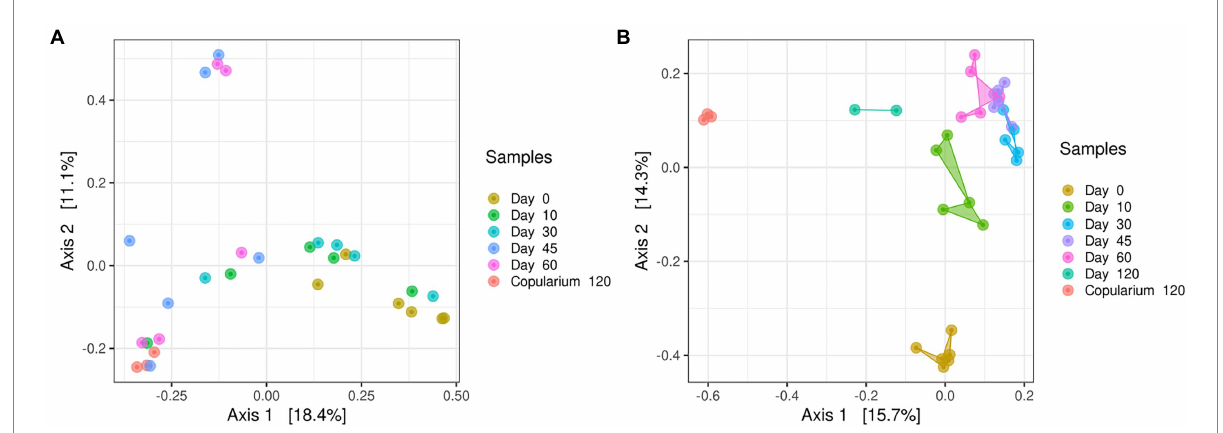
FIGURE 4 PCoA based on Bray-Curtis distances displaying the change in the structure of the mycobiome (A) and of the bacteriome (B) in the gut of M. subhyalinus reproductives over the colony foundation period, in comparison with the copularium at day 120. Day 0 to day 60 for fungi, and day 0 to day 120 for bacteria refer to gut samples at the corresponding time points.